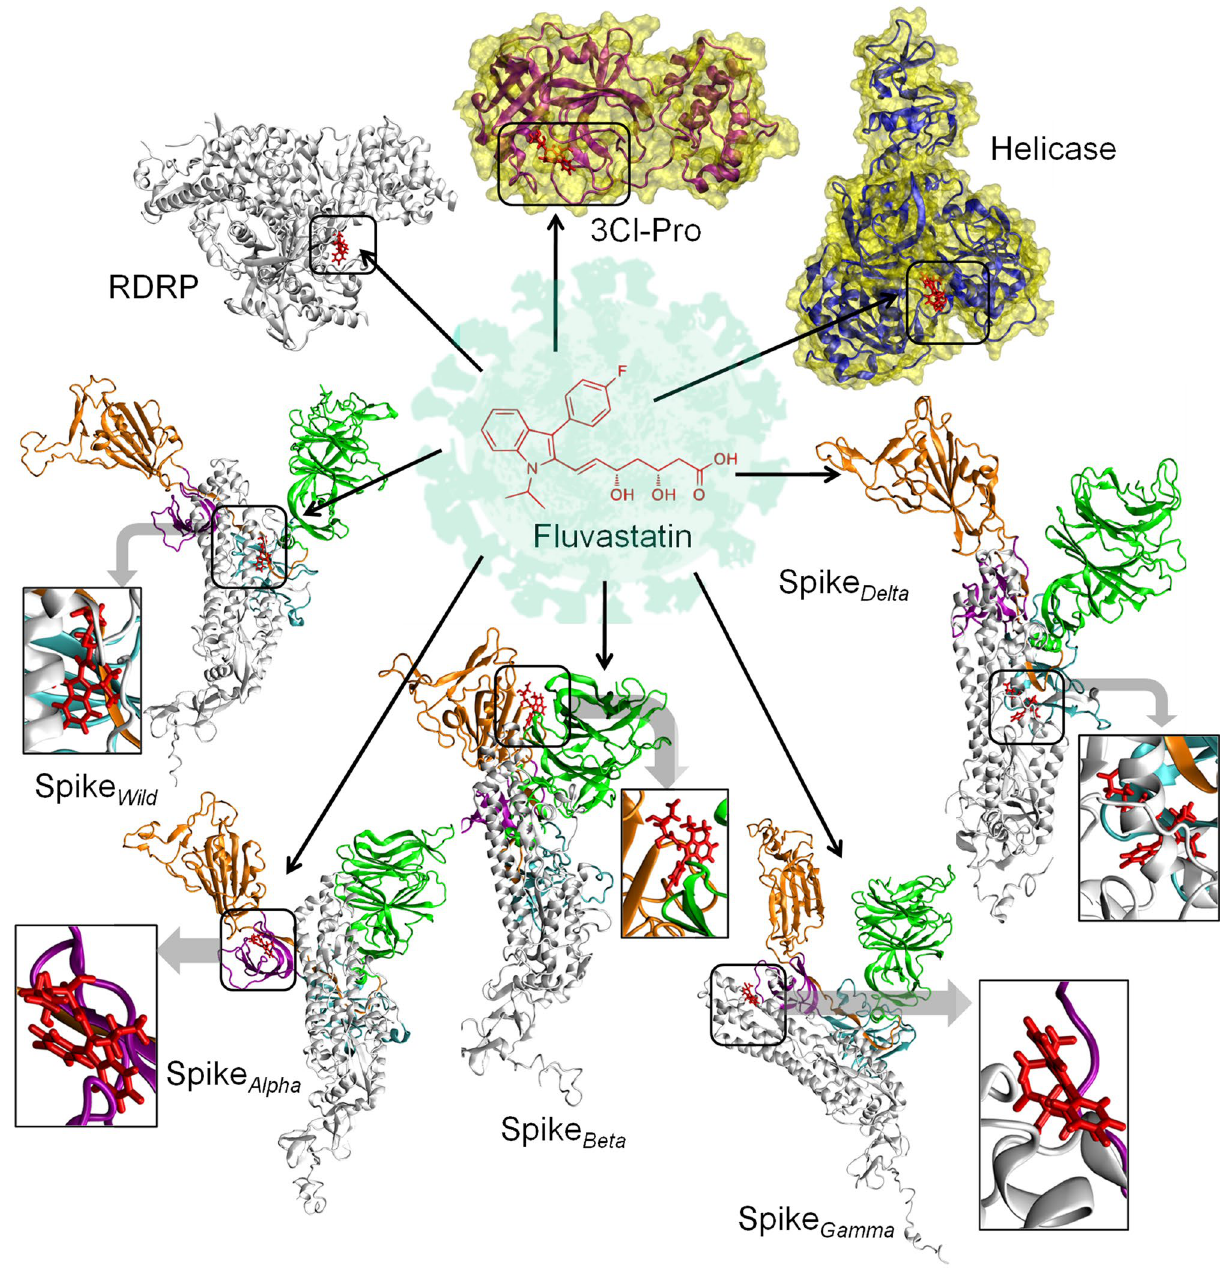
Figure 13. Schematic diagram of the interaction of fluvastatin with the SARS-CoV-2 target proteins. The 2D image of fluvastatin was drawn by ChemSketch, Advanced Chemistry Development, Inc. software (https:// www. acdla bs. com/ resou rces/ freew are/ chems ketch/) and the schematic diagram of COVID-19 virus were drawn by INKSCAPE (version 1.1), an open-source graphics-design software (https:// inksc ape. org/), used as